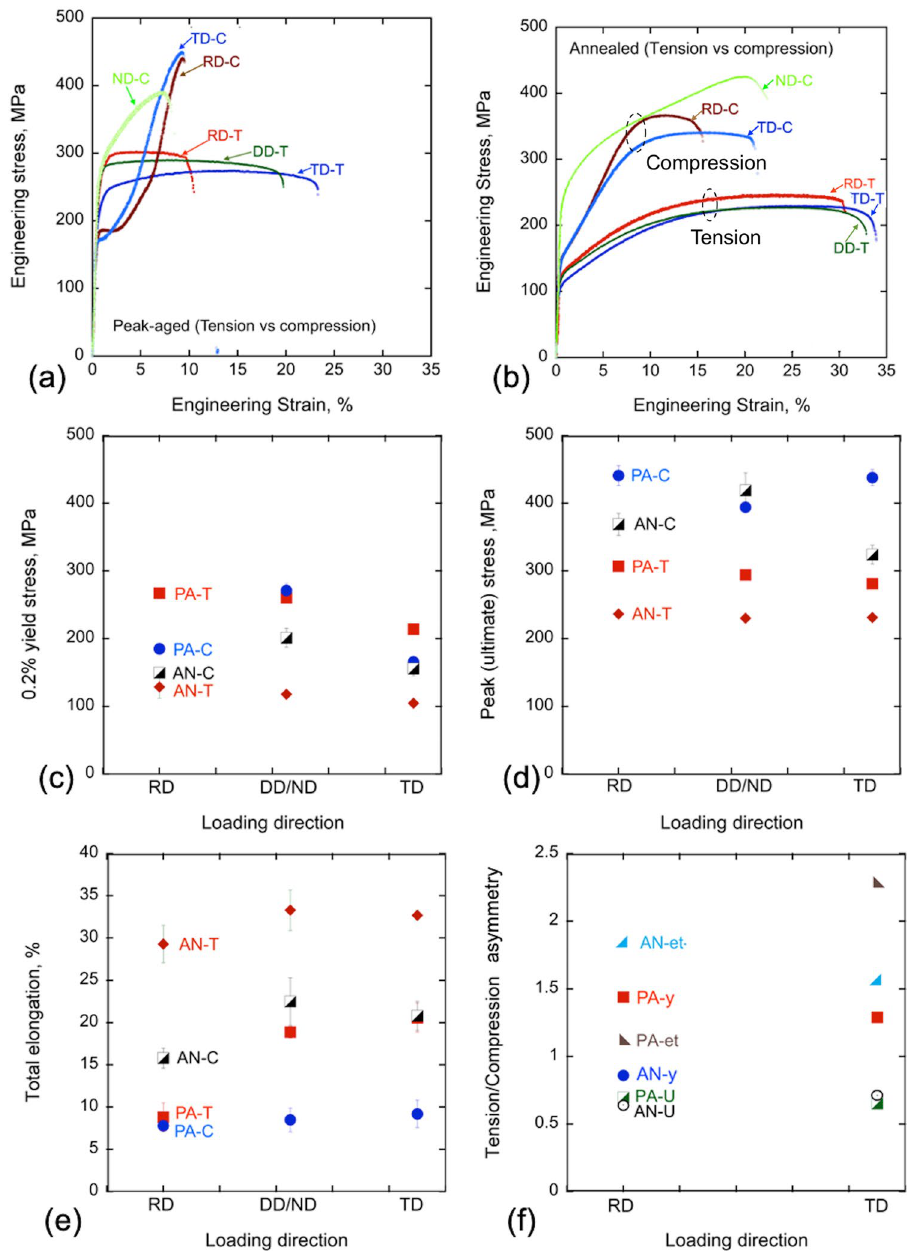
Figure 3. Room temperature engineering stress–strain (s–e) curves in tension and compression for the ( a ) peak-aged and ( b ) annealed samples. ( c )–( e ) show their 0.2% yield stress, peak or ultimate strength, and elongation to failure, respectively. ( f ) the tension/compression asymmetry in the peak-aged and annealed